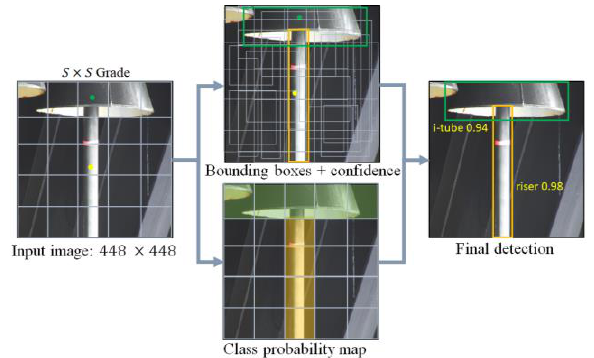
Figure 3. YOLO. The input is divided into a grid, followed by the multiplication of the confidence prediction of the bounding boxes and the class probabilities, generating a final detection result. Each boundary box contains five components: (𝑥, 𝑦, 𝑤, ℎ, 𝑐𝑜𝑛𝑓). The (𝑥, 𝑦) coordinates represent the center of the box, relative to the grid cell location (the grid cell responsible for the object). The (𝑤, ℎ) represents the width and height of the predicted box. The last component is the prediction confidence (𝑐𝑜𝑛𝑓) . Lastly, adding the class predictions to the output vector, the YOLO algorithm produces a tensor output with the shape (𝑆 × 𝑆(𝐵